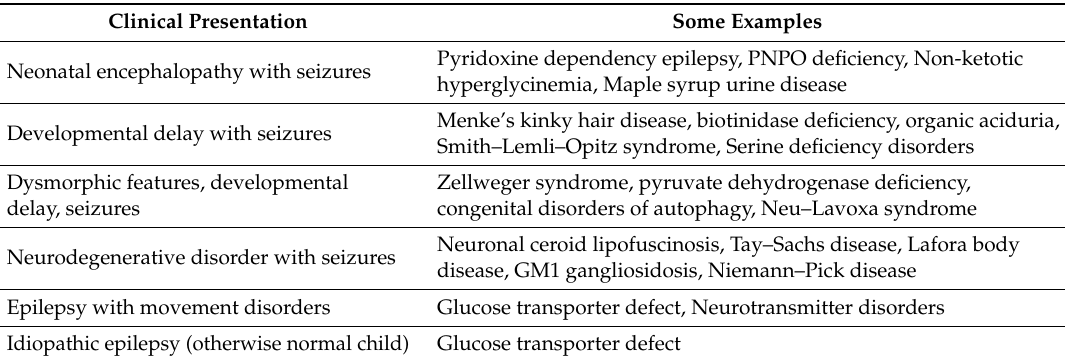
Table 2. Phenotypic presentations of epilepsy associated with